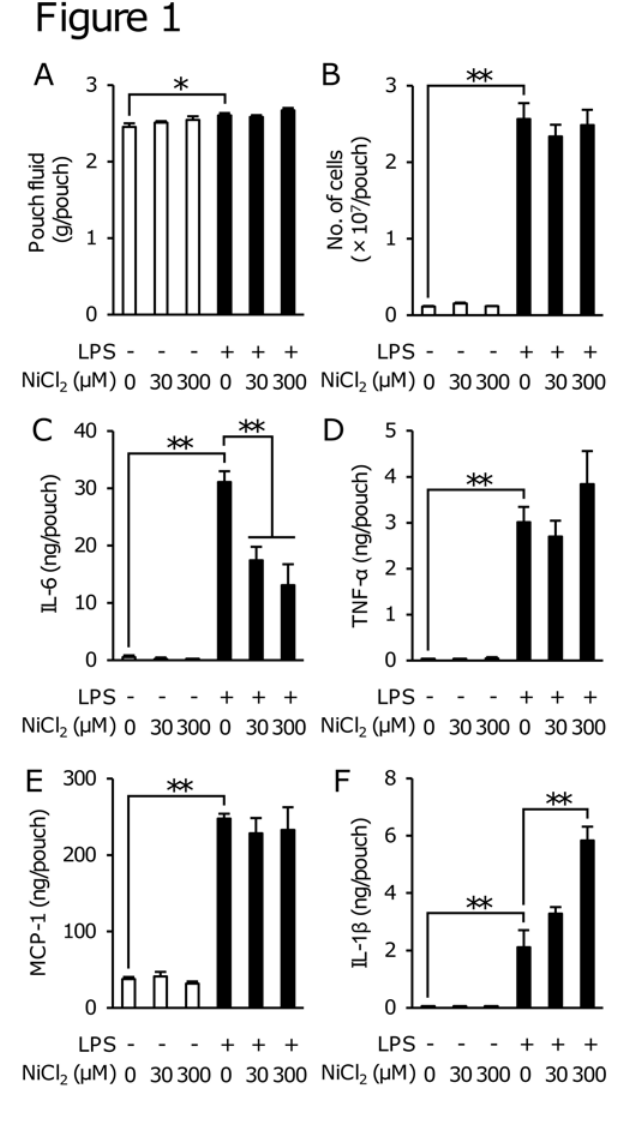
Fig 1. Effects of NiCl2 on LPS-induced inflammation in mice. Two milliliters of CMC-Na solution containing NiCl 2 (30 or 300 μ M) in the presence or absence of LPS (10 ng/ml) was injected into the air pouch, and the pouch fluid was then collected 8 h after the stimulation. The pouch fluid weight (A) and number of leukocytes in the pouch fluid (B) were measured and the concentrations of IL-6 (C), TNF- α (D), MCP-1 (E), and IL-1 β (F) were determined by ELISA. Data represent the mean ± S.E.M. (n = 6, 7). * p < 0.05 and ** p < 0.01 between the indicated